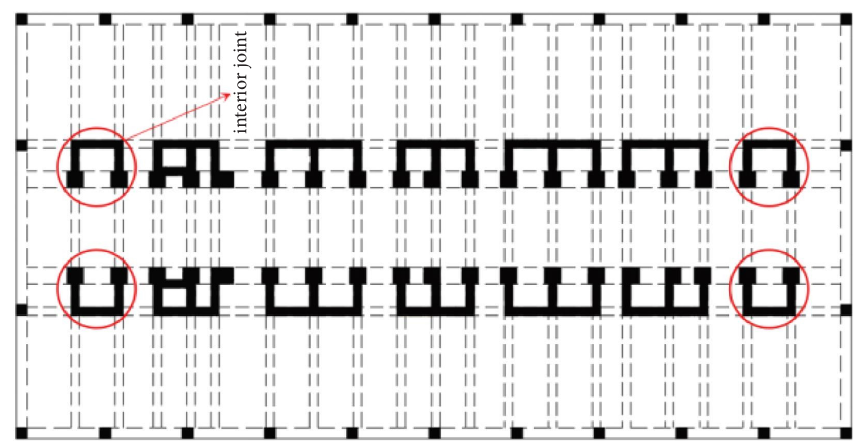
Figure 2: Architectural plan with a prototype U -shaped section wall.